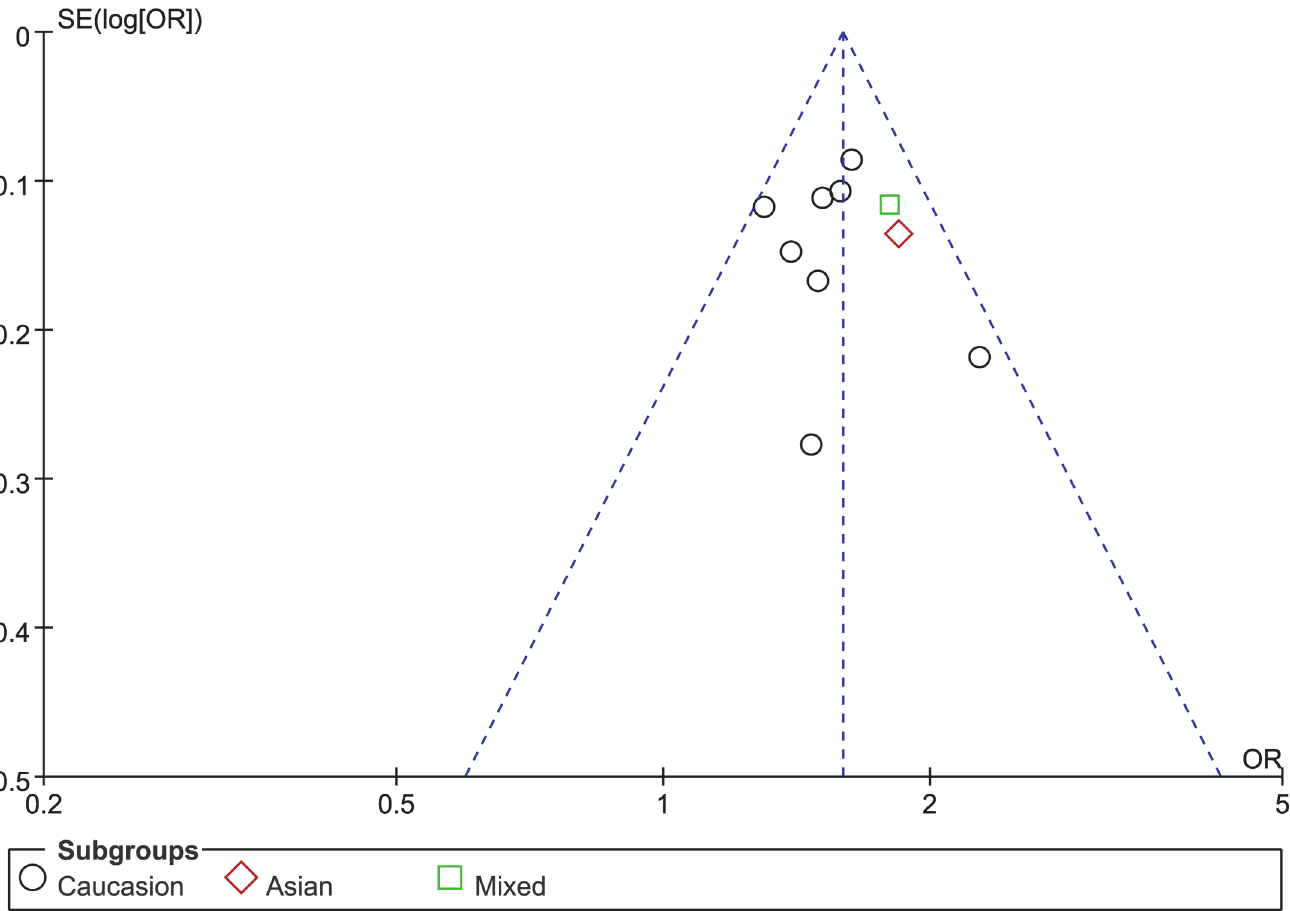
Fig 5. Funnel plot for evaluation of publication bias in the included studies on the association of BTNL2 rs2076530 polymorphism and sarcoidosis susceptibility in A vs